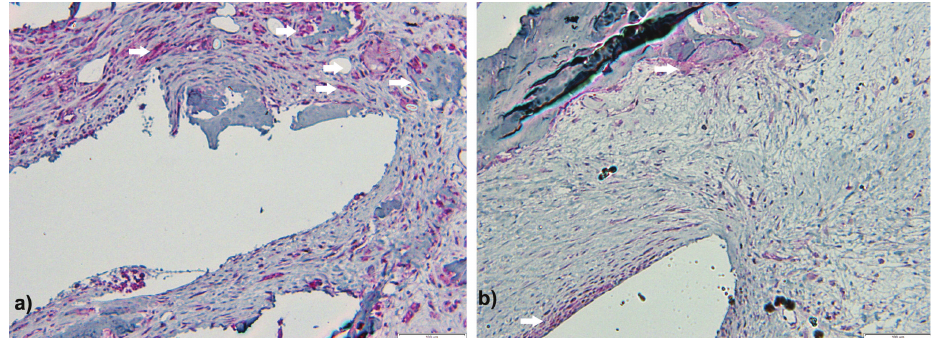
Figure 7: Microphotograph of decalcified sections, osteopontin (white arrows) and PCNA expression. Picture shows Z3 areas of femoral: (a) actuator and (b) static control, suggesting more extensive osteopontin labeling around actuator. Double Fast-Red and DAB immunohistochemistry staining for osteopontin and PCNA, respectively. Scale bar represents 100 µ